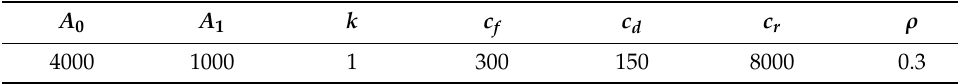
Table 1. Parameters for the numerical example.